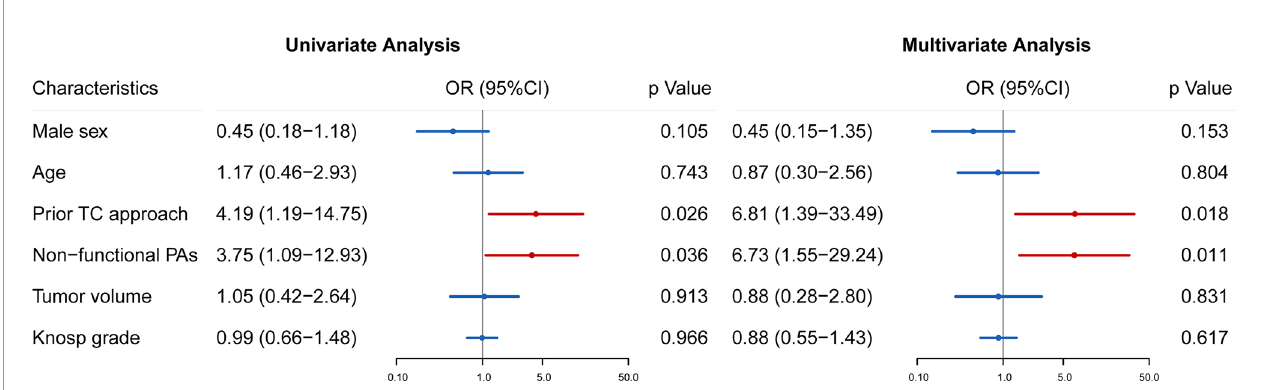
FIGURE 4 | Univariate and multivariate analyses were used to identify risk factors for intraoperative CSF leakage in reoperation of rrPAs. Odds ratio (OR), 95% con fi dence intervals (CI) and p value are exhibited for comparison.